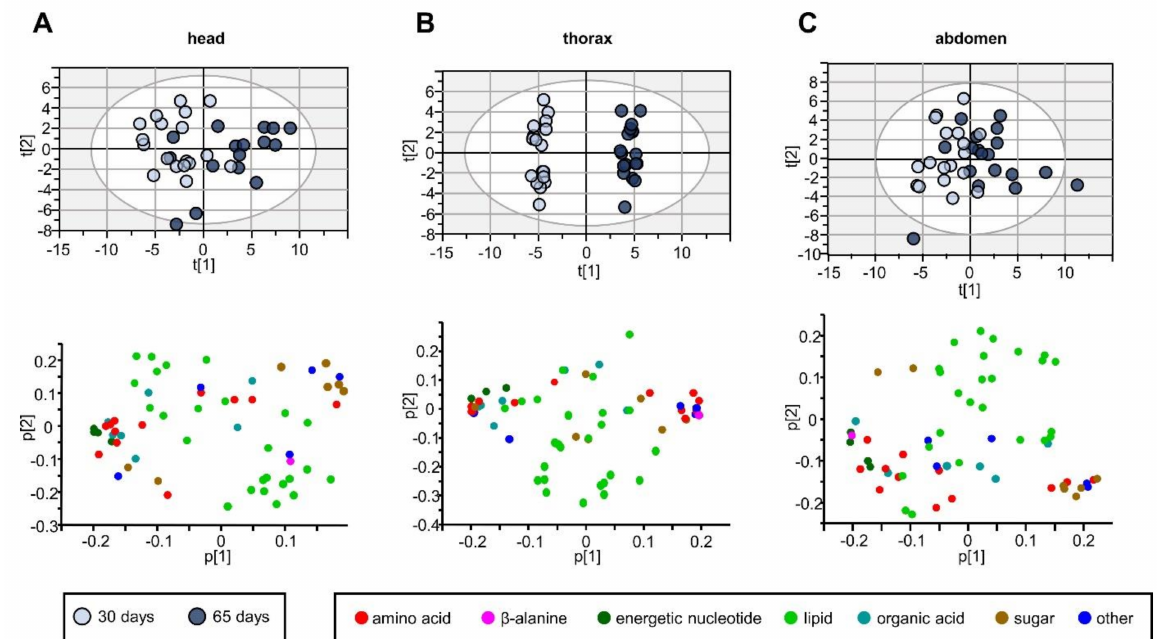
Figure 2. PCA and loading plot of the 30- and 65-day extracts of the three anatomical regions. ( A ) PCA score and plot of head extracts, UV scaling, 6 components, head R2X (cum) = 0.71, Q (cum) = 0.40. ( B ) PCA score and loading plot of thorax extracts, UV scaling, 6 components, head R2X (cum) = 0.72, Q (cum) = 0.47. ( C ) PCA score and loading plot of abdomen, UV scaling, 6 components, head R2X (cum) = 0.72, Q (cum) =